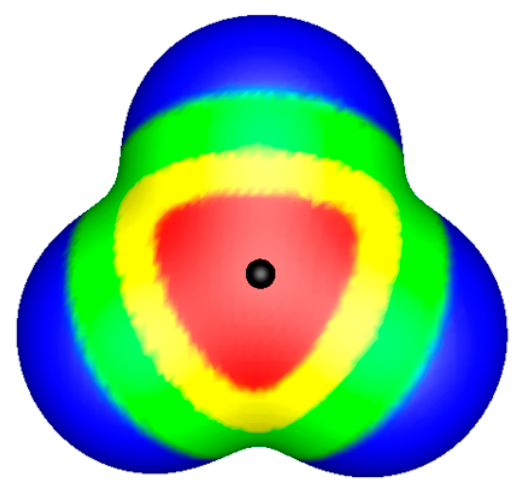
Figure 2. Computed electrostatic potential on the 0.001 au molecular surface of SeO 3 . Selenium is in the center. Color ranges, in kcal / mol: red, more positive than 36; yellow, between 36 and 18; green, between 18 and 0; blue, negative. Black hemisphere indicates the most positive potential (V S,max ) corresponding to the π -holes above and below selenium.